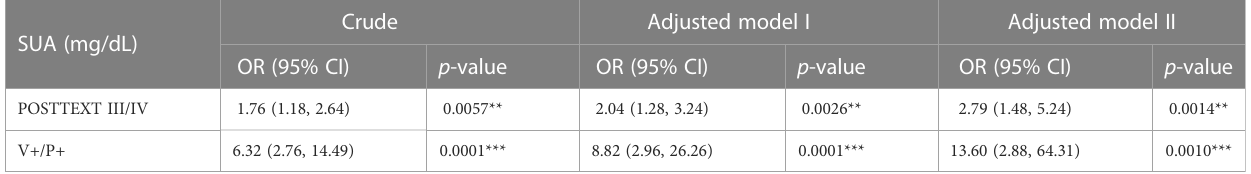
TABLE 5 The evaluation of SUA after neoadjuvant therapy with POSTTEXT staging and vessel